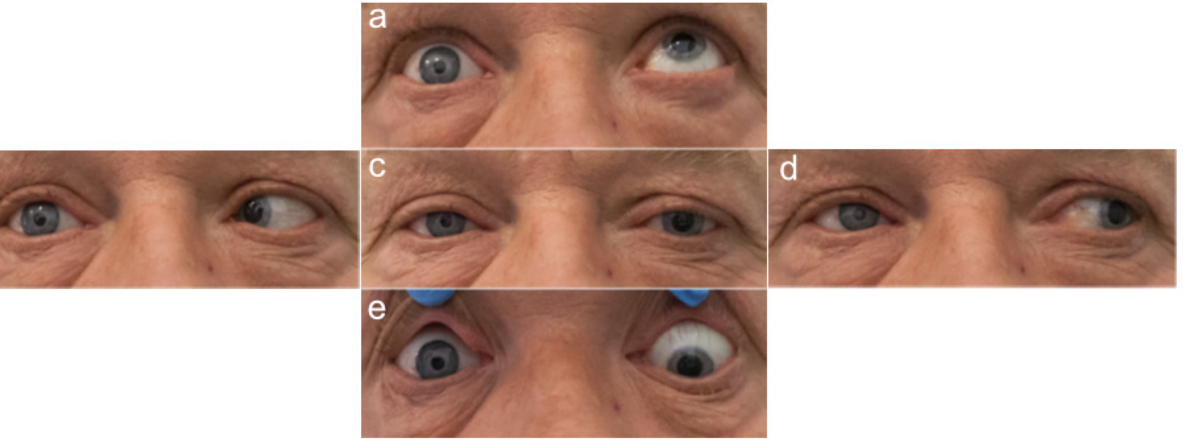
Figure 2. Photographs of a patient with an orbital implant and a glass prosthetic eye on the right; five cardinal directions of gaze: ( a ) up, ( b ) to the right, ( c ) straight ahead, ( d ) to the left, and ( e ) down. Source: Division of Ophthalmology and Ocular Oncology, Jagiellonian University Medical College; own material.